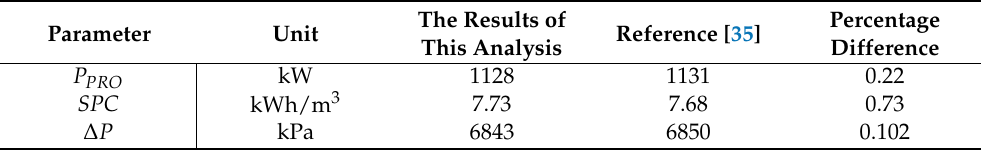
Table 8. Validation results for the RO system.